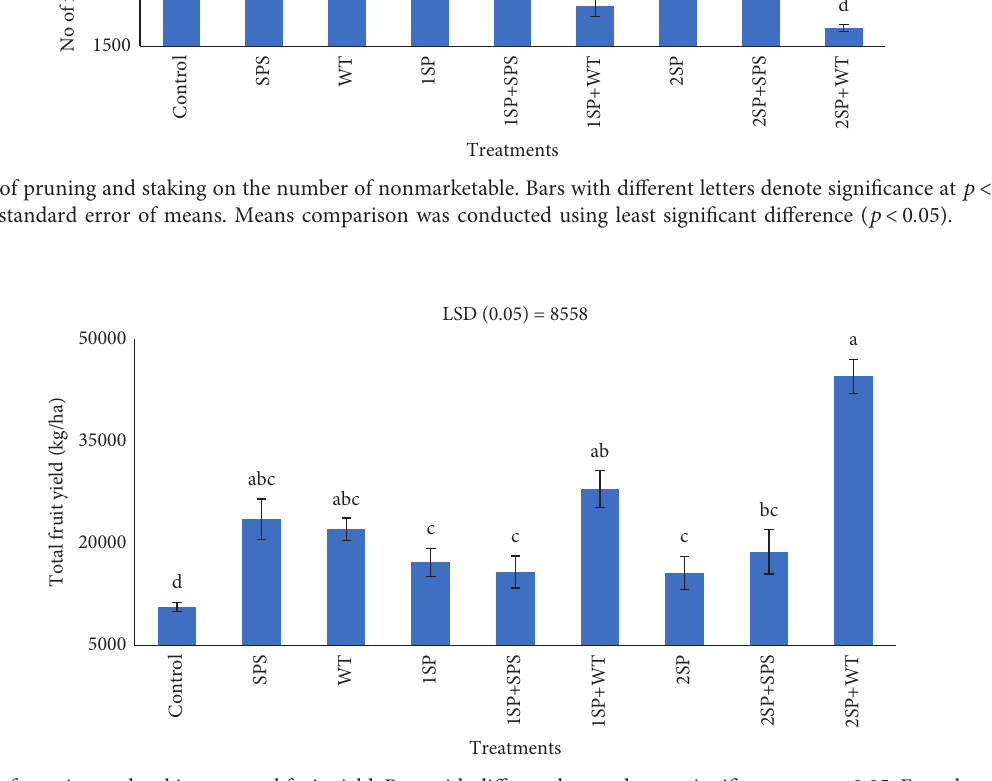
Figure 5: Effect of pruning and staking on total fruit yield. Bars with different letters denote significance at p < 0 . 05. Error bars denote the standard error of means. Means comparison was conducted using least significant difference ( p < 0 .